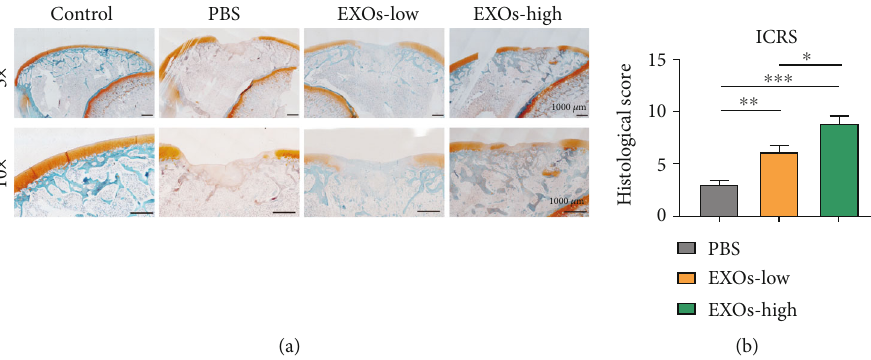
Figure 6: hBMSC-EXOs promote cartilage repair in rabbits. (a) Saf-O/Fast Green staining. Scale bar = 1000 μ m . (b) The International Cartilage Repair Society (ICRS) scores. n = 3 . Values are presented as mean ± SEM . ∗ P < 0 : 05 , ∗∗ P < 0 : 01 , and ∗∗∗ P < 0 : 001 , one-way ANOVA. EXOs-low: 1 × 10 10 /ml ; EXOs-high: 5 × 10 10 /ml